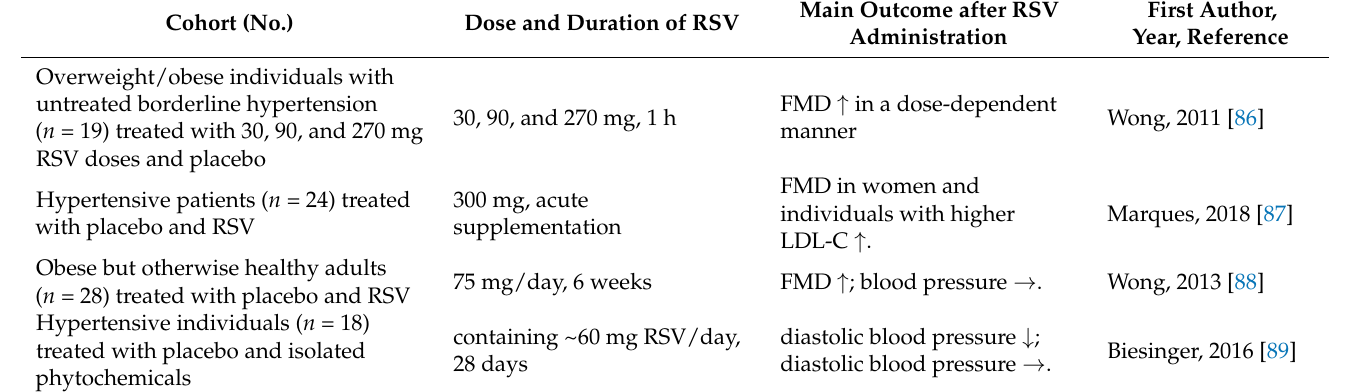
Table 2. Summary of clinical trials involving the use of RSV in